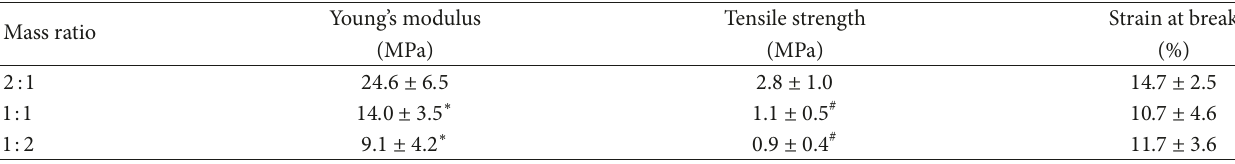
Table 1: Mechanical properties of chitosan/PEO blend fibers at various rations.